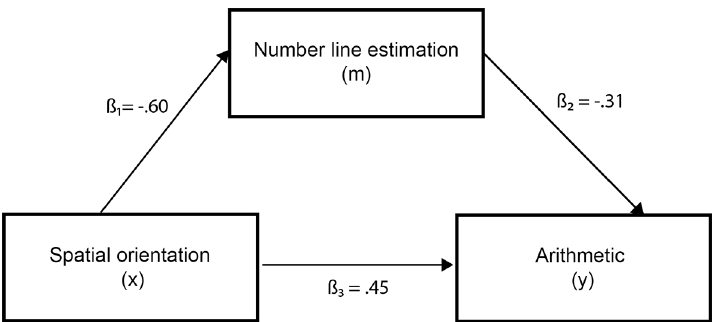
Figure 2. Mediation Model with Spatial Orientation as Independent Variable (x), Number Line Estimation as Mediator (m) and Arithmetic as Dependent Variable